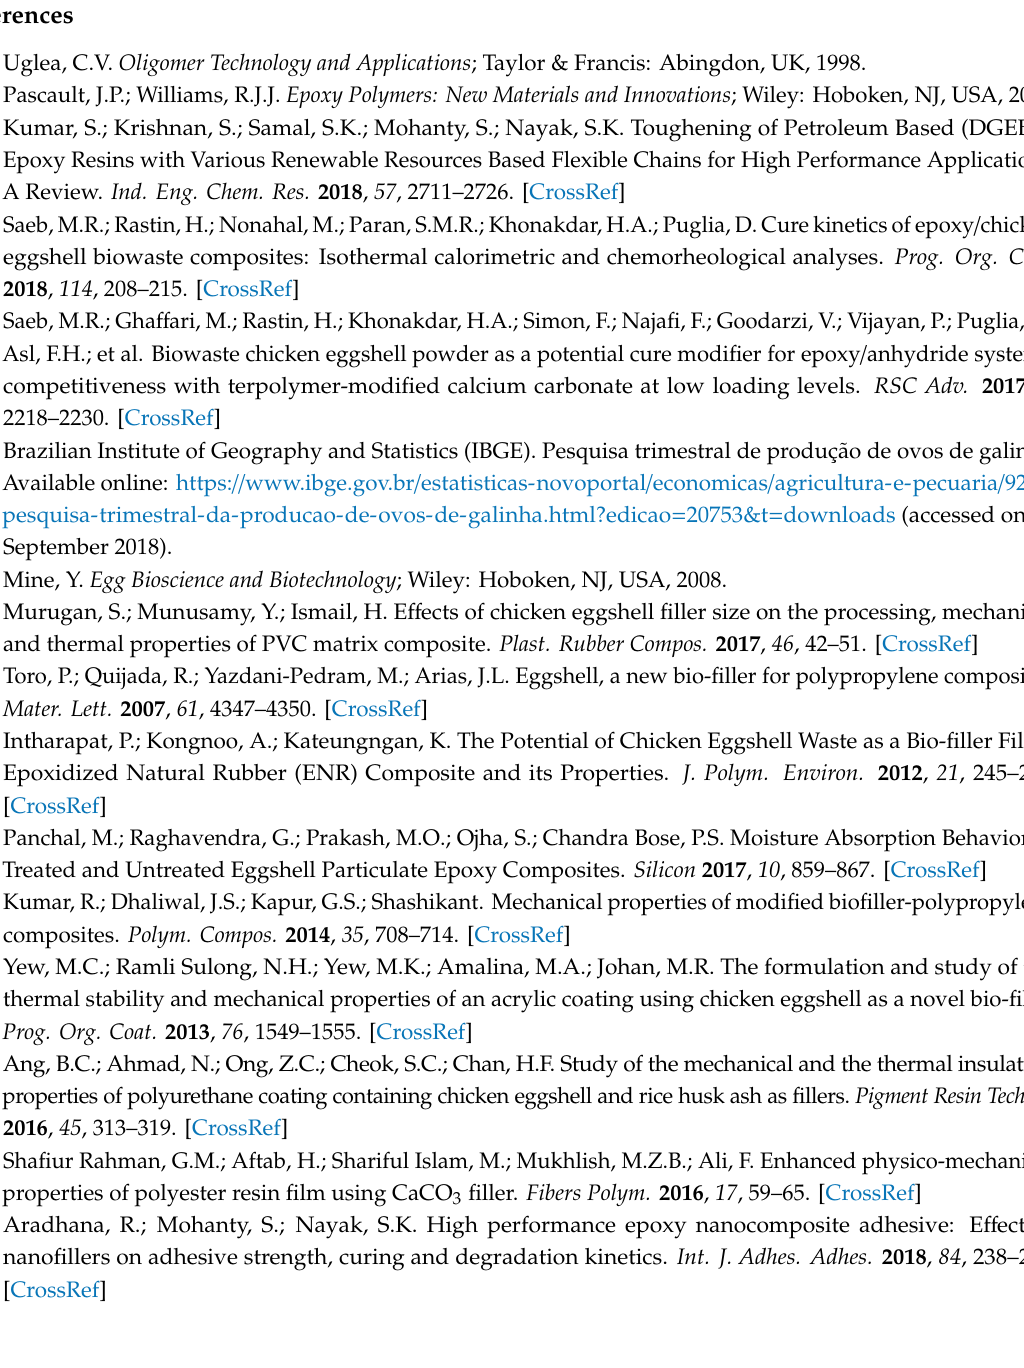
di ff erent compositions; Figure S8: DSC scans of E X / EM X / M X , at indicated heating rates; Figure S9: DSC scans of E X / EM X / M X , at indicated heating rates; Figure S10: Degree of conversion of M X at indicated heating rates; Figure S11: Conversion rate of M X at indicated heating